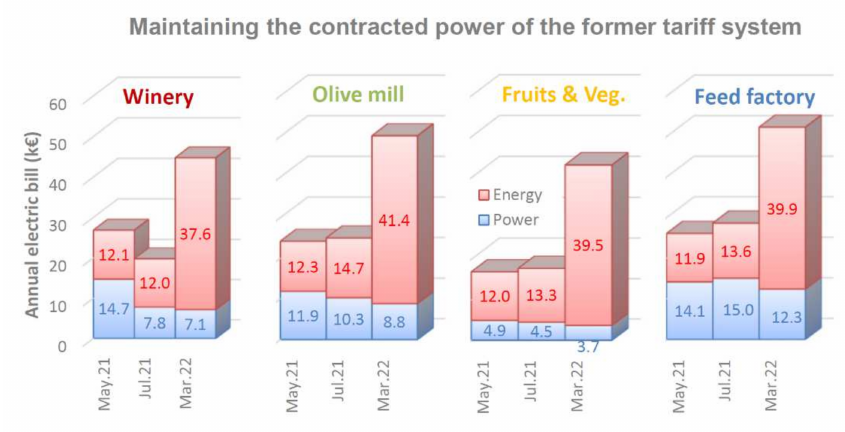
Figure 7. Annual electricity bill amount under three different scenarios and prices, maintaining the contracted power of the former tariff system: former tariff system with prices as of May 2021, current tariff system with prices as of July 2021, and current tariff system with current prices as of March